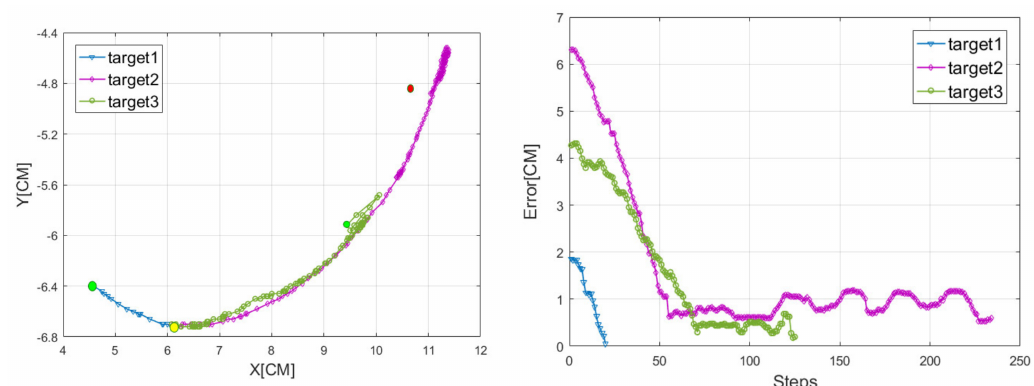
Figure 8. The End of Soft arm: Motion Trajectory and Error for Load = 2.